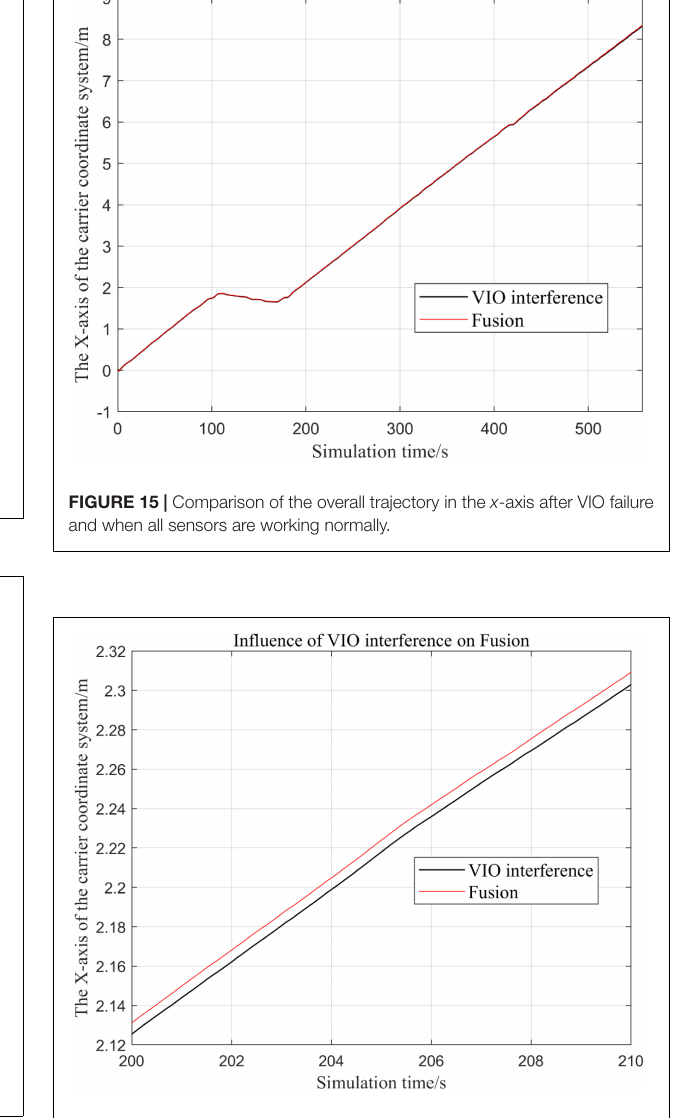
FIGURE 16 | Comparison of local trajectory in x -axis after VIO failure and when all sensors are working